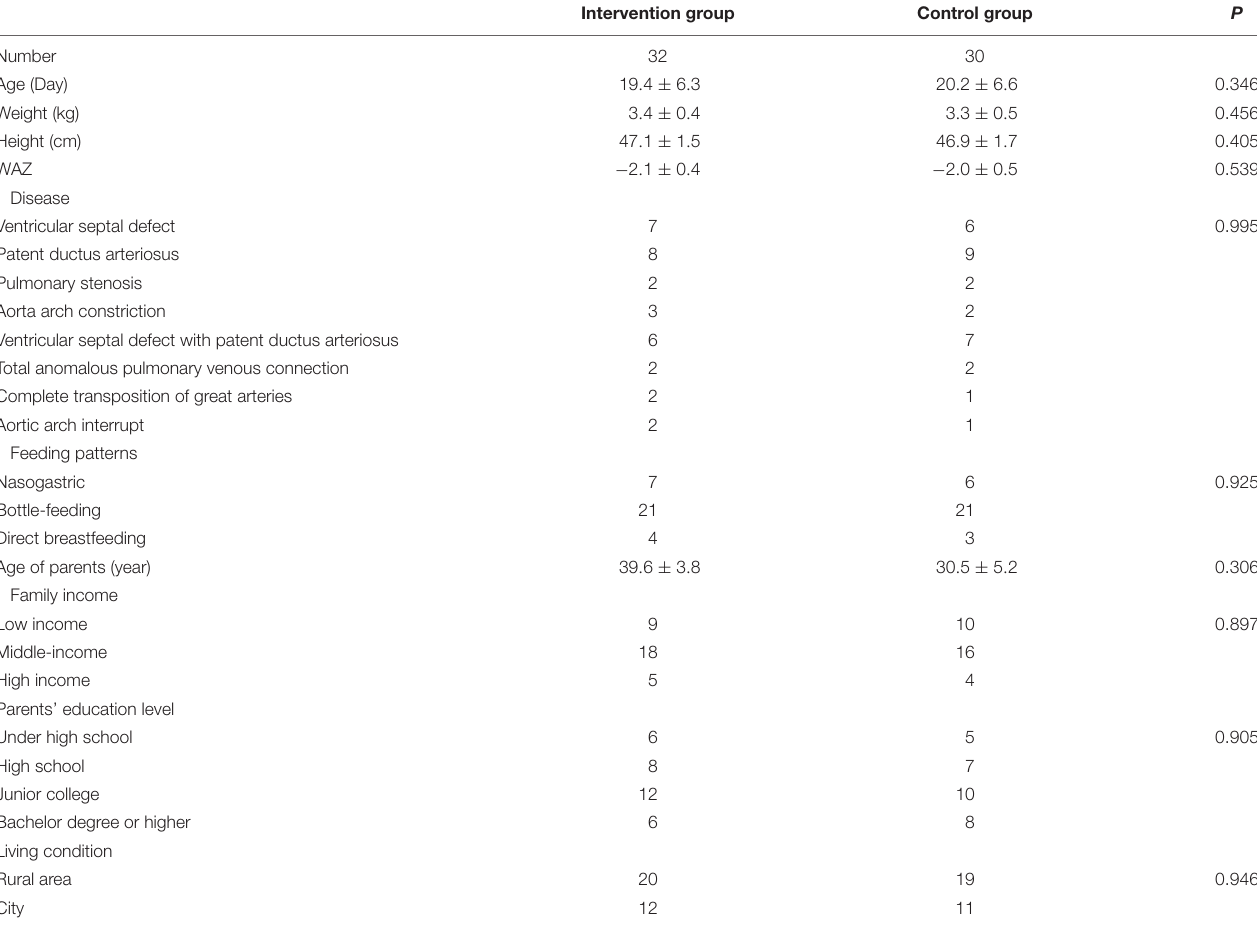
TABLE 1 | Demographic data of patients and their parents in two groups at discharge. Intervention group Control group P